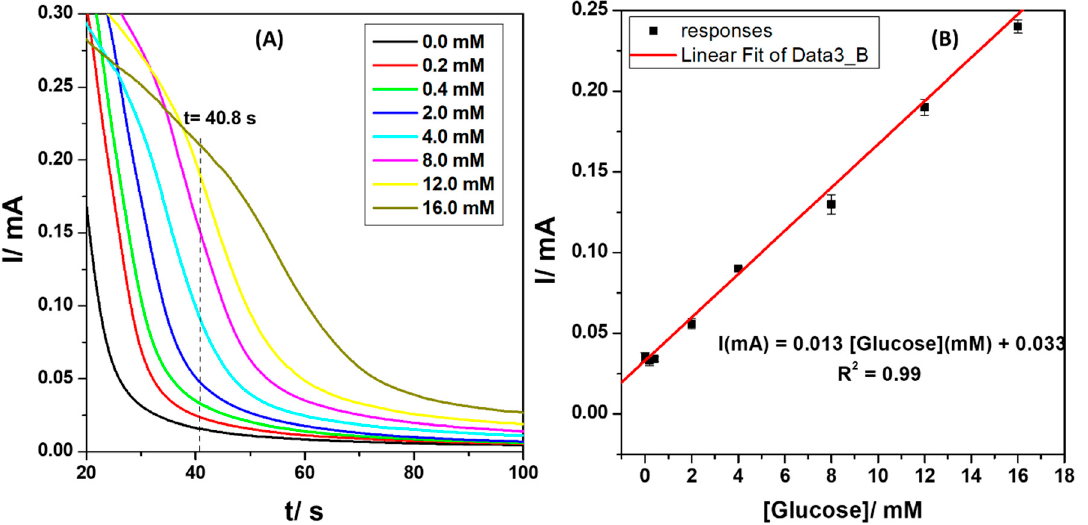
Figure 8. ( A ) Chronoamperometry responses of CuS-2-modified SPCE at different concentrations of glucose (0.2 to 16 mM) in 0.01 M phosphate buffer solution and ( B ) the corresponding calibration curve.